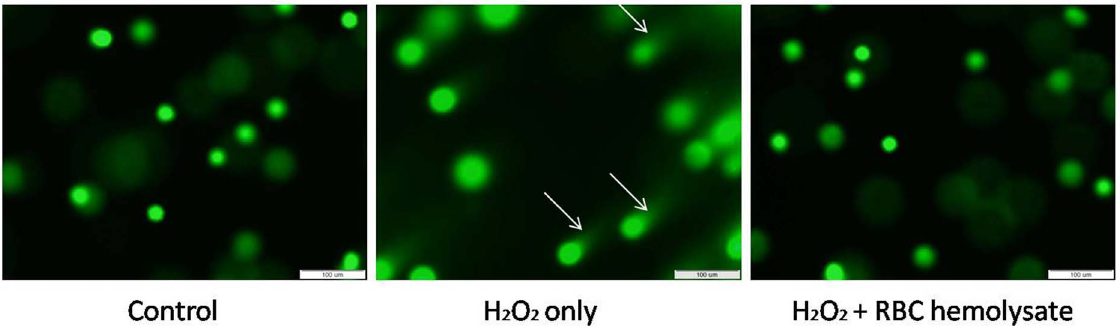
Figure 7. Comet assay – a representative experiment (N=3). The left image depicts the control. The middle image depicts the effect of H 2 O 2 . The right image depicts the effect of H 2 O 2 and RBC hemolysate.